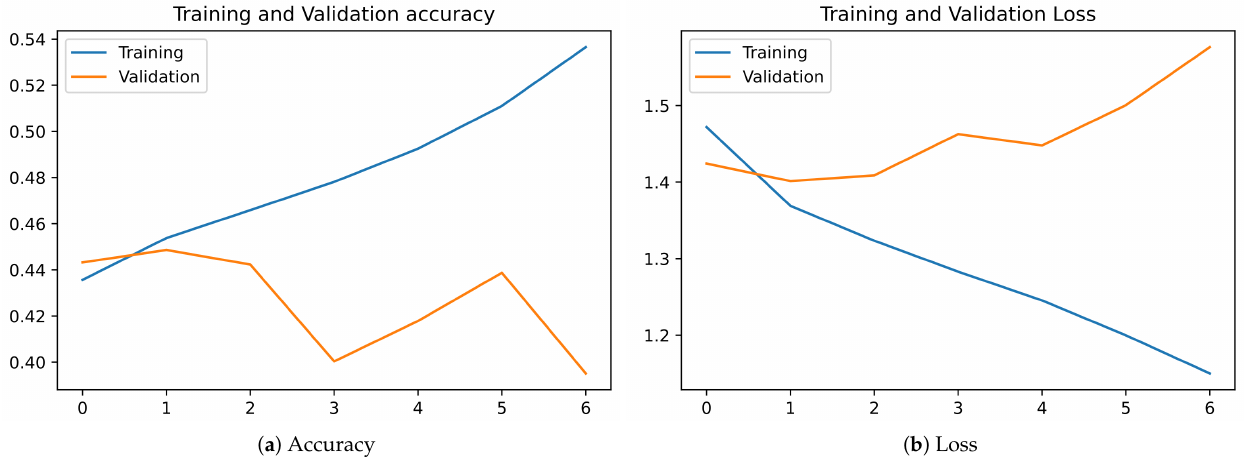
Figure 14. Performance of the rating prediction model Figure 20. Performance of the rating prediction